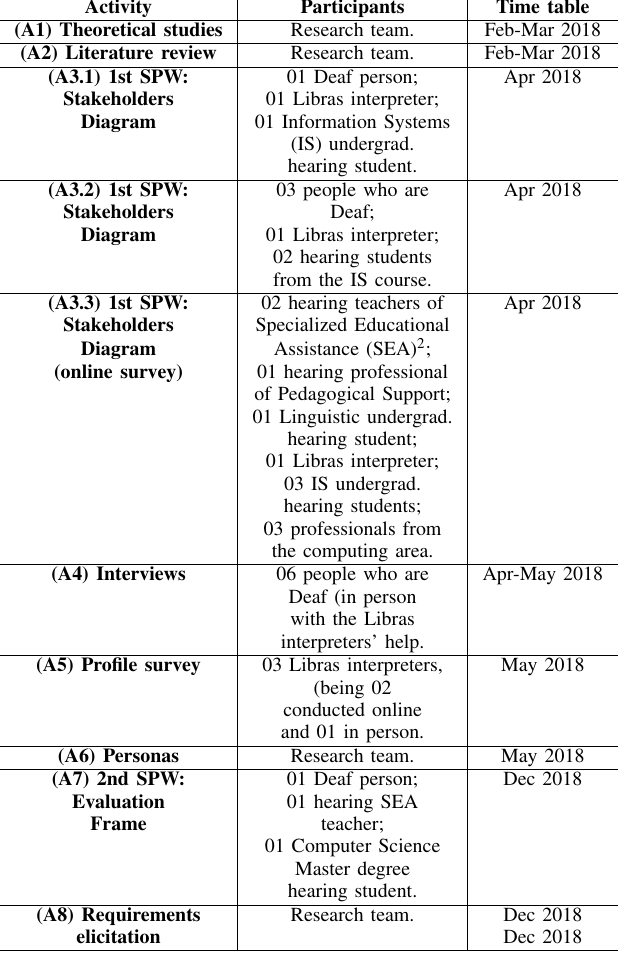
TABLE I A CTIVITIES (A#), P ARTICIPANTS AND T IME TABLE OF THE E XPLORE AND U NDERSTAND